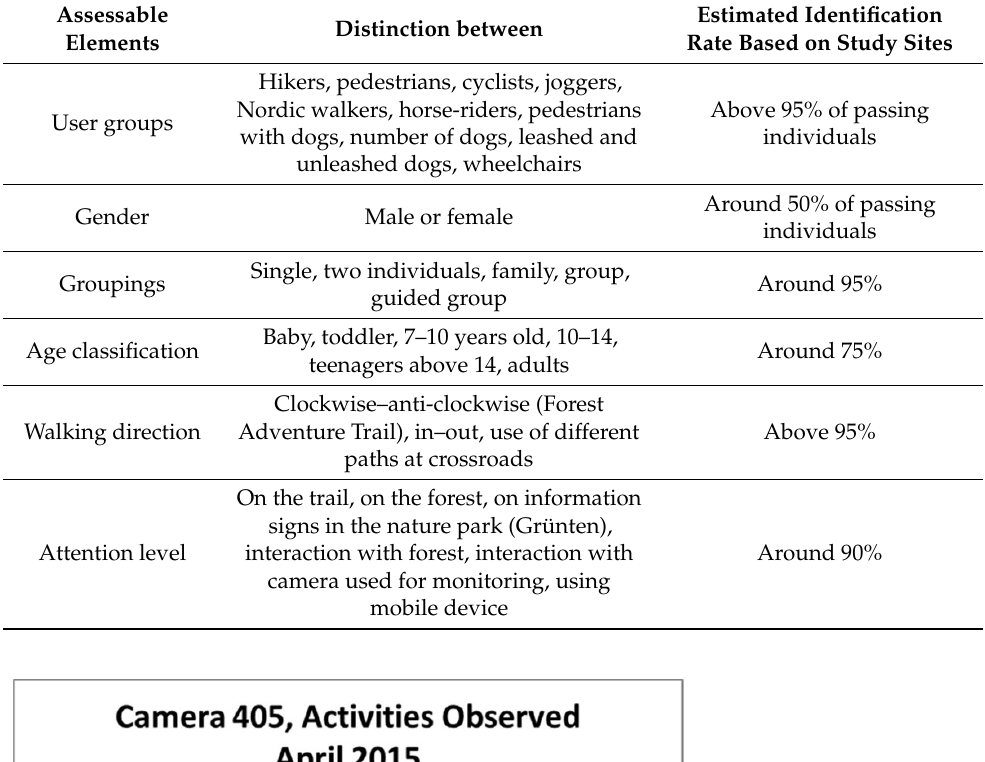
Table 2. Assessable attributes of visitors using trigger trail cameras and estimated identification rates based on assessing the pictures.